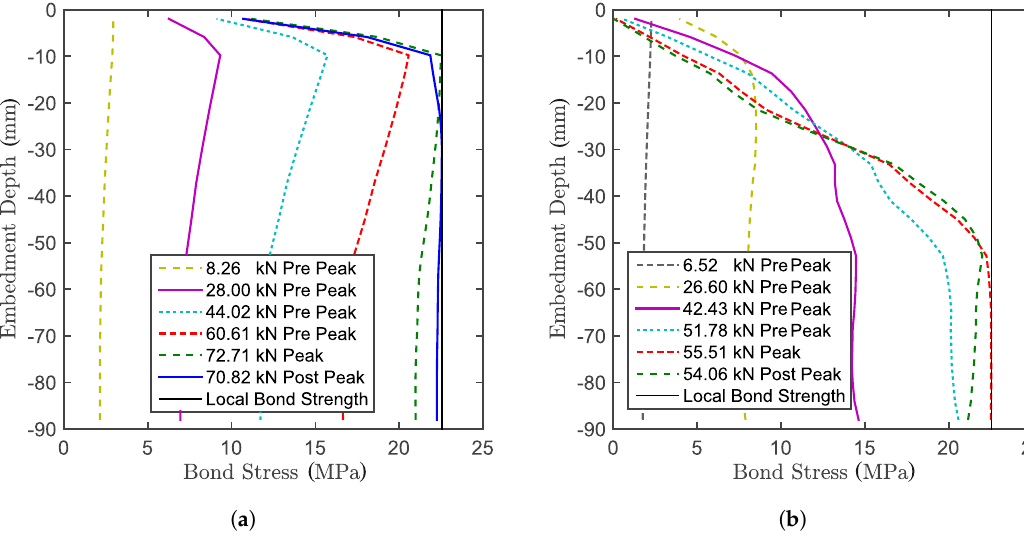
Figure 12. Bond stress along the anchor in numerical simulations for the ( a ) confined setup and ( b ) unconfined